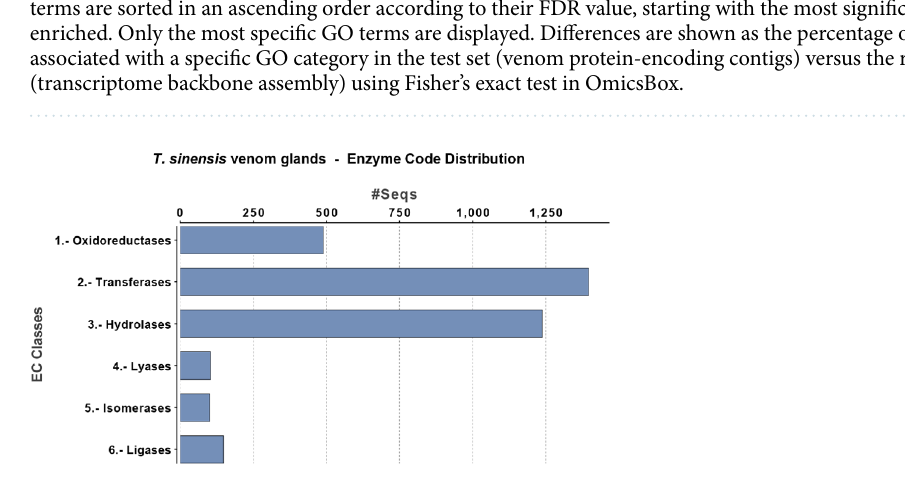
Figure 5. Enzyme Code (EC) Classes of the T. sinensis contigs encoding enzymes. The most abundant families of enzymes found in the transcriptome of T. sinensis venom glands are